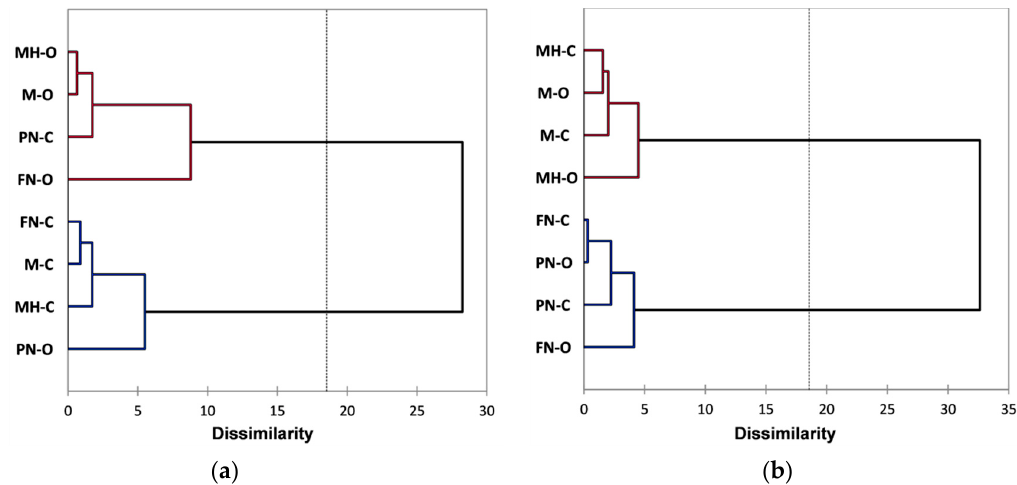
Figure 6. Dendrograms showing the cluster patterns for red grape seed extracts based on: ( a ) FTIR data; ( b ) Raman data.